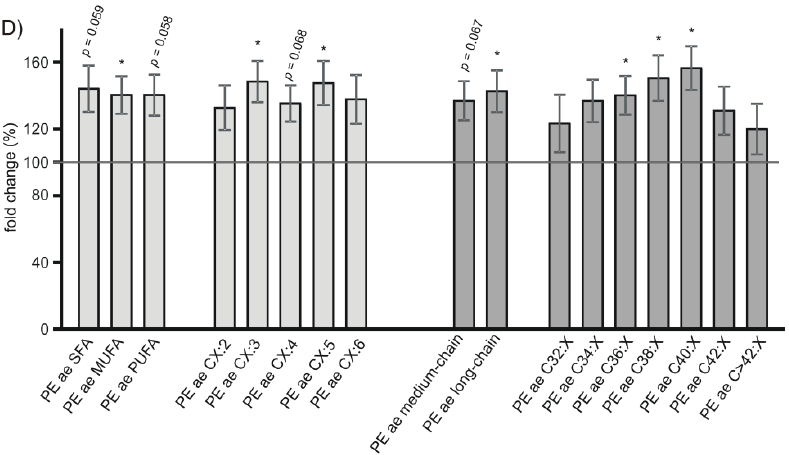
Figure 10. Processed data. ( A ) Fold changes of ω6/ ω3 relation-related ratios of analyzed phospho- lipid species in SH-SY5Y APPswedish cells compared to mock-transfected cells. Error bars represent the standard error of the mean (SEM). Statistical significance was calculated using two-tailed Stu- dent’s t -test. ( B ) Fold changes of different phospholipid species containing three double bonds in SH-SY5Y APPswedish cells compared to mock-transfected cells. Error bars represent the standard error of the mean (SEM). Statistical significance was calculated using two-tailed Student’s t -test. ( C , D ) Fold changes of phosphatidylethanolamines and plasmalogens in respect to their saturation and chain length in SH-SY5Y APPswedish cells compared to mock-transfected cells. Error bars rep- resent the standard error of the mean (SEM). Statistical significance was calculated using two-tailed Student’s t -test with * p ≤ 0.05 and ** p ≤ 0.01.